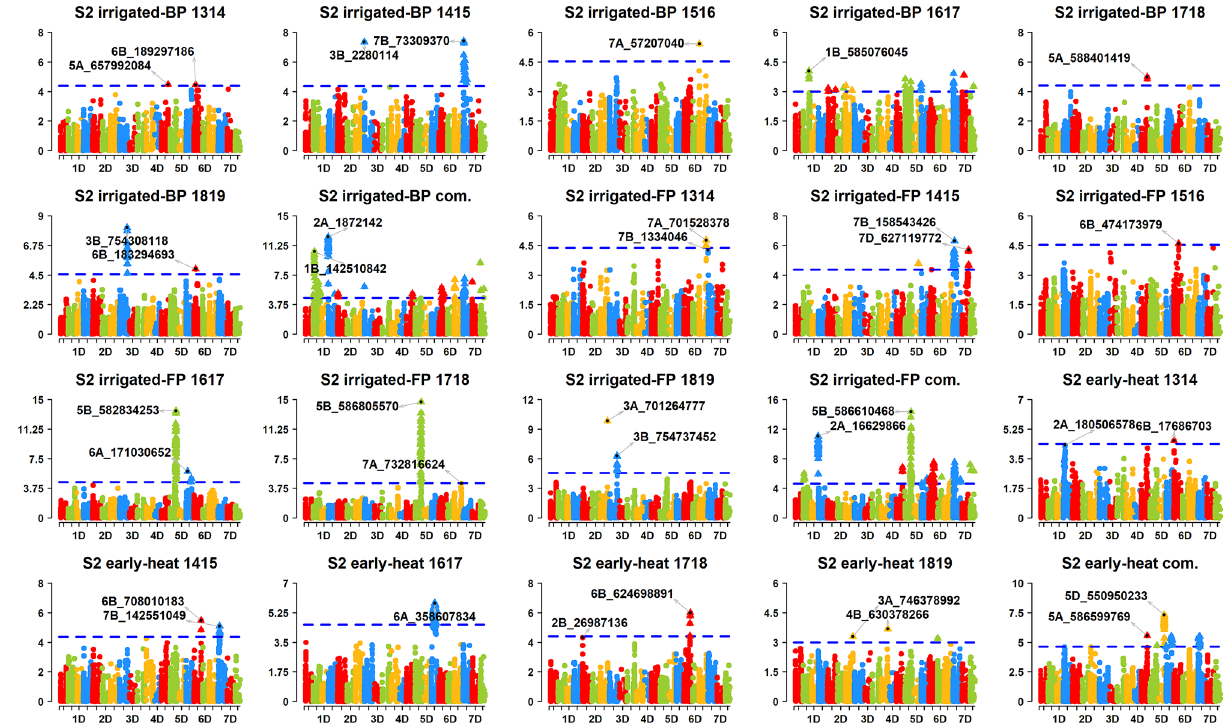
Figure 3. Markers significantly associated with grain yield in the Stage 2 (S2) yield trials evaluated in the irrigated-bed planting (S2 irrigated-BP), irrigated-flat planting (S2 irrigated-FP) and early-heat (S2 early-heat) environments at Obregon (Mexico), during the 2013–2014 (1314), 2014–2015 (1415), 2015–2016 (1516), 2016– 2017 (1617), 2017–2018 (1718) and 2018–2019 (1819) crop cycles and in the combined (com.) analysis across crop cycles. The chromosomes are shown in the x-axis and the –log 10 p values in the y-axis. The threshold lines correspond to the threshold using the Bonferroni correction for multiple testing at an α level of with GY in multiple environments 10 . On chromosome 2AL, Yld.cim-2AL.1 and Yld.cim-2AL.2 (68 cM) between 345,975,712 and 478,911,698 bps were associated with GY in the S1 irrigated-BP 1718 and Ludhiana 1718 (MAE of 144.5 kg/ha) datasets and flanked the cell wall invertase gene TaCwi-A1 associated with kernel weight 26 . On chromosome 2BS, Yld.cim-2BS.2 to Yld.cim-2BS.4 between 53,295,873 and 59,220,243 bps (60.5–61.4 cM) were associated with GY in the S1 1516 and S2 1617 irrigated-BP, S1 1718 and S2 1819 irrigated-BP, S1 and S2 irrigated-BP combined, S1 irrigated-BP 1617, S1 irrigated-BP 1718 (MAE of 64.3 kg/ha), S1 irrigated-BP com- bined and S2 irrigated-BP combined datasets. Yld.cim-2BS.5 at 77.7 cM between 155,142,247 and 157,266,347 bps was associated with GY in the Ludhiana 1415, Ludhiana 1617 (MAE of 261 kg/ha) and Ludhiana 1819 data- sets. On the centromeric region of chromosome 2B, Yld.cim-2BS.7 and Yld.cim-2BL.1 (78.5–84 cM) between 184,319,808 and 437,544,036 bps were associated with GY in the S2 late-heat 1617 (MAE of 98 kg/ha) and S2 late-heat combined datasets. Among these, Yld.cim-2BS.2 to Yld.cim-2BS.4 were in the same location as the Photoperiod-B1 gene associated with flowering time 27 , while Yld.cim-2BS.5 to Yld.cim-2BS.7 and Yld.cim-2BL.1 flanked a region associated with TKW 28 . On chromosome 2DS, Yld.cim-2DS.1 (13.8 cM) at 14,747,094 bps was associated with GY in the Jabalpur combined, Ludhiana combined and Pusa combined datasets and was in the same position as Qcim.2D.1 associated with GY in Ludhiana and Pusa 10 . On chromosome 2DL, Yld.cim-2DL.1 to Yld.cim-2DL.7 (82.4–101 cM) between 572,256,847 and 620,582,835 bps were associated with GY in the S1 irrigated-BP 1617 and S1 irrigated-BP 1718 (MAE of 68.4 kg/ha) datasets, while some of them were also associ- ated with GY in the S1 irrigated-BP 1516 dataset. Grain yield associations in group 3 homeologous chromosomes.